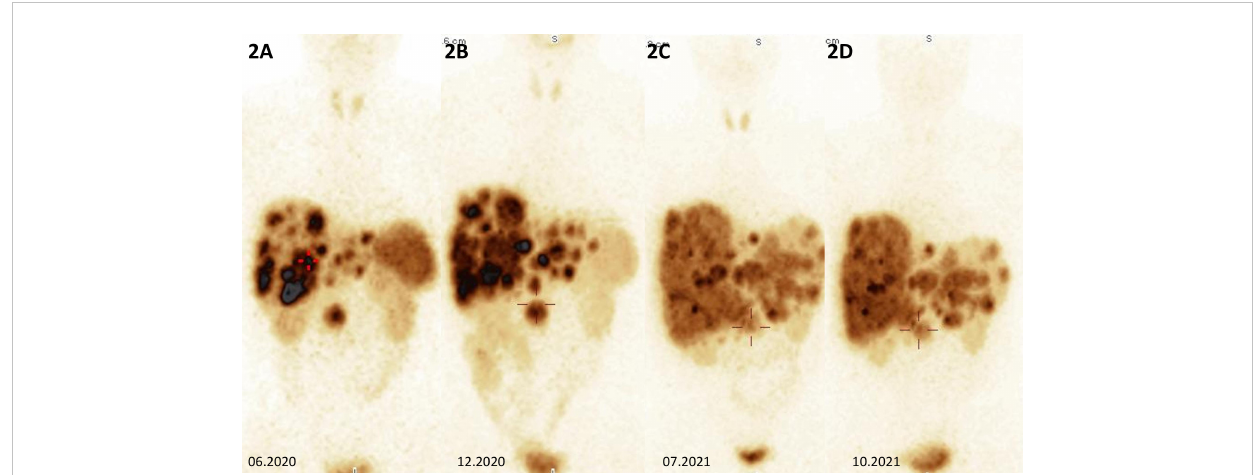
FIGURE 2 (A) Somatostatin receptor scintigraphy of the abdomen showing multiple metastases in the liver, primary tumor in the head of the pancreas with high somatostatin receptor expression in all lesions, and incidentaloma of the left adrenal gland without pathological radiolabel uptake. (B, C) Somatostatin receptor scintigraphy showing metabolically receptor-mediated progression within the liver and primary tumor of the pancreatic head. (D) Somatostatin receptor scintigraphy showing metabolic receptor-mediated stabilization within metastatic lesions in the liver, with a decrease in liver size and a primary tumor of the head of the pancreas with similar radioimmunoassay accumulation after CAPTEM